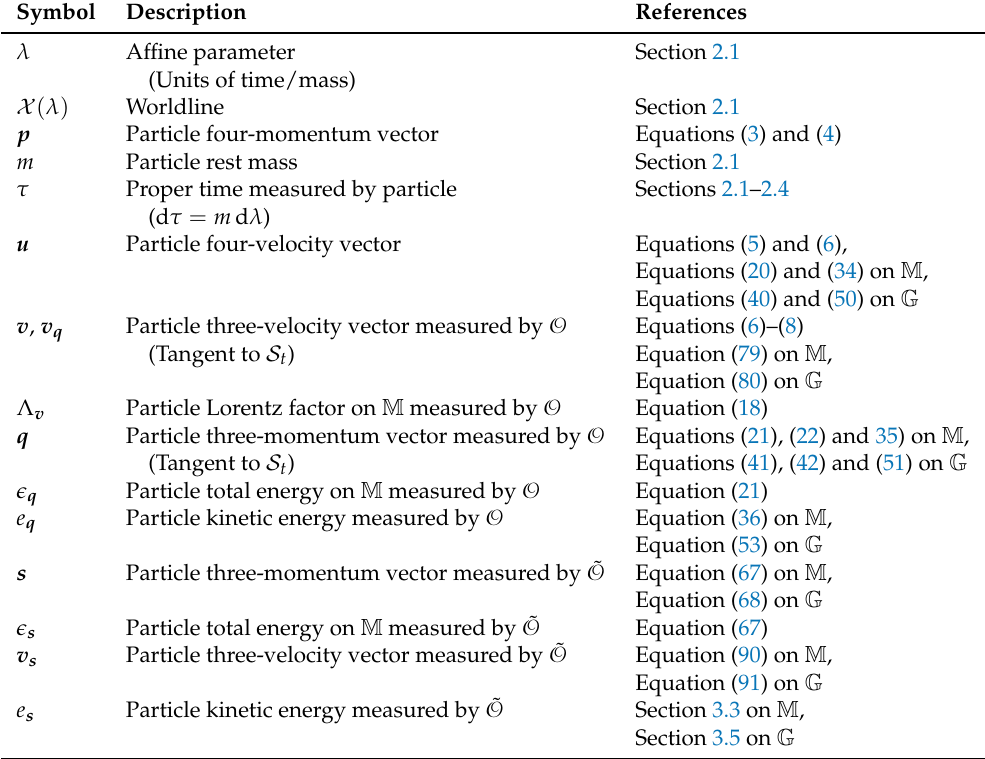
Table 2. Geometric entities characterizing particles on Minkowski and Galilei/Newton spacetimes.